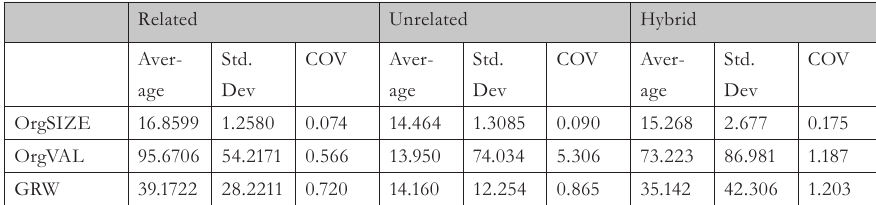
Tab. 3 – Comparison of the Control Variables (Size, Value and Growth) for Related, Unrelated and Hybrid Diversification Strategies. Source: own